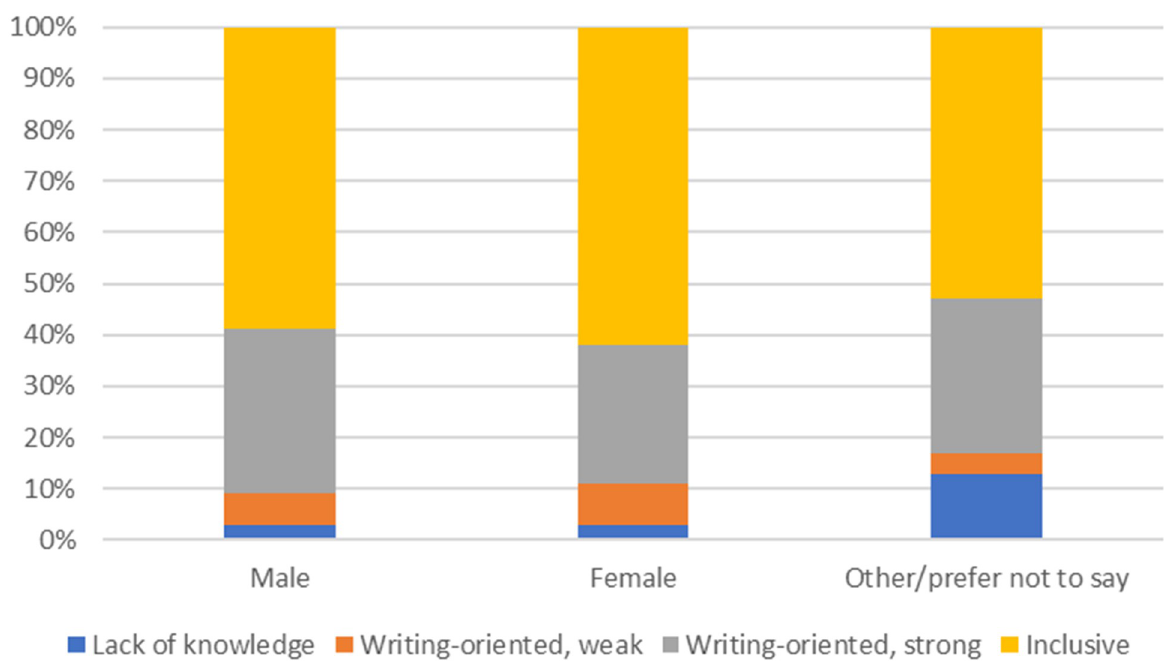
Fig 4. Distribution of authorship views across gender identification (shares based on predicted probabilities).